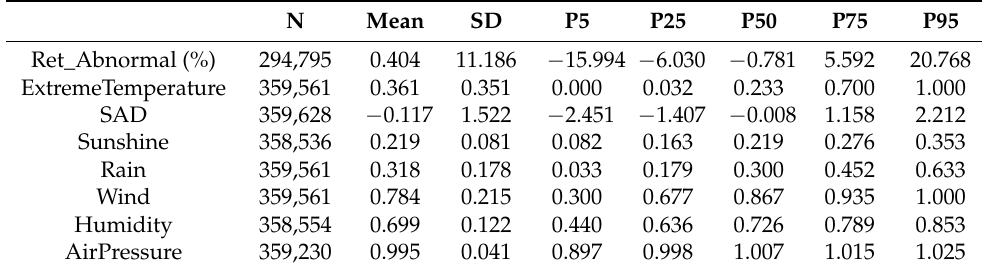
Table 2. Summary statistics of